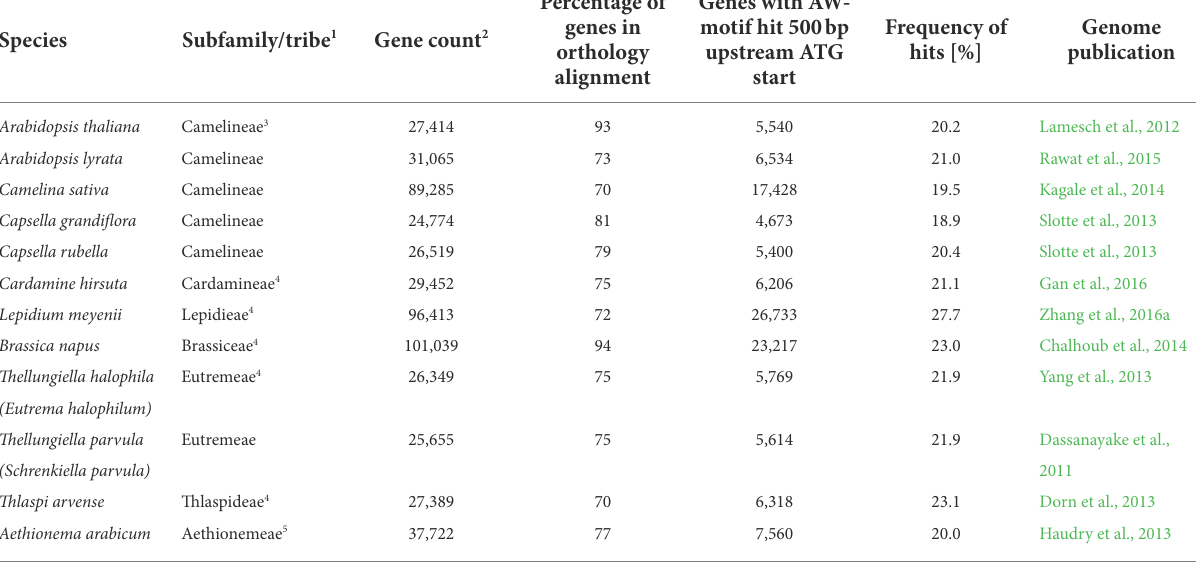
TABLE 2 Species used in the phylogenetic foot printing approach and main results of genome mining for syntenic orthology relations and promoter regions.